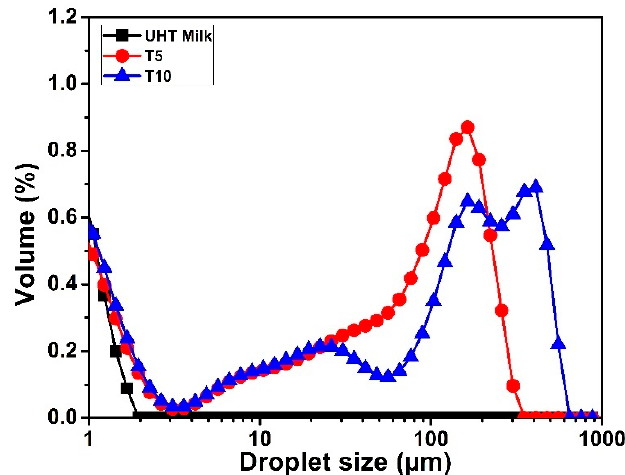
Figure 7. Follow-up of the particle size distribution using static light scattering (SLS) analysis during the first 10 minutes of heating. UHT milk before heating (control) ■ after 5 min of heating ● and after 10 min of heating ▲ .